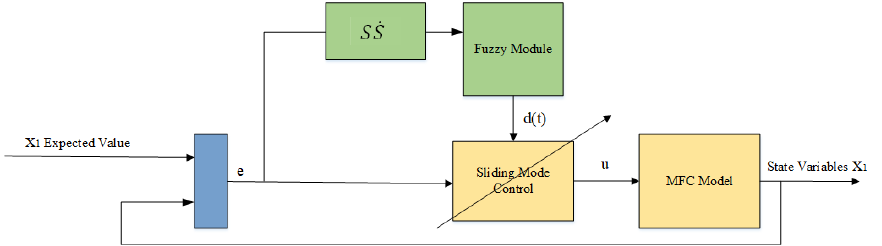
Figure 2. Schematic diagram of the control